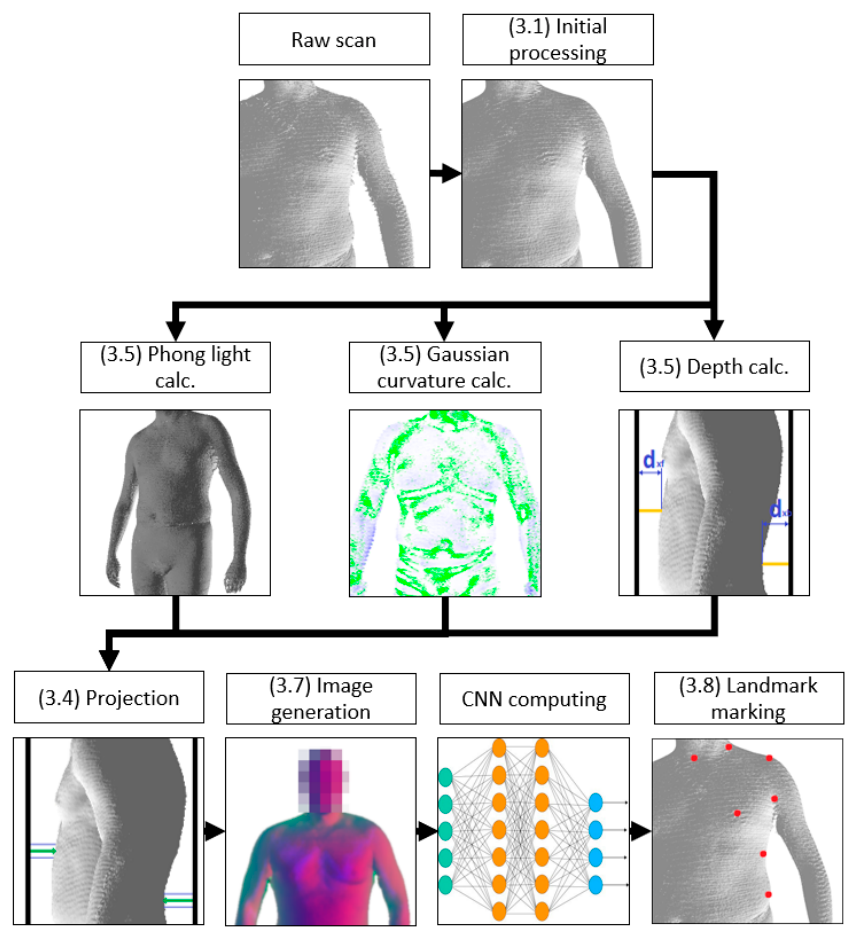
Figure 3. Workflow of orthogonal projection method.